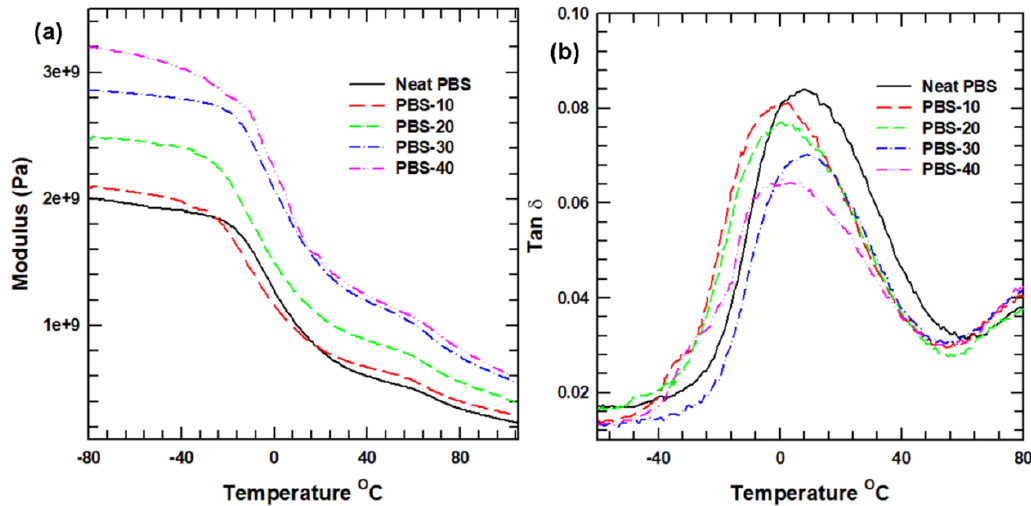
Figure 6. Viscoelastic properties of the neat PBS and the PBS composites: ( a ) storage modulus and ( b ) loss factor.